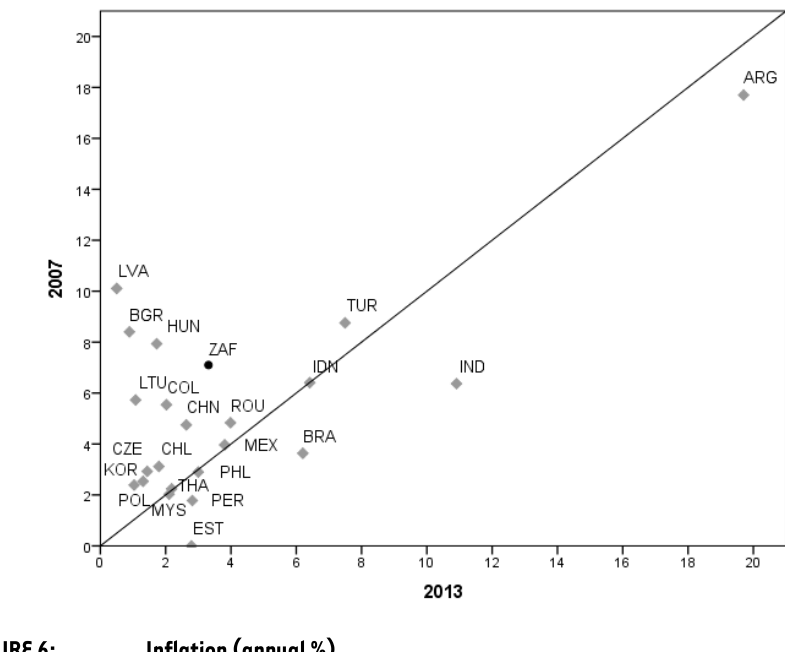
FIGURE 5: Government debt (% of GDP) Source: Authors’ depiction of data from The World Bank: World Development Indicators